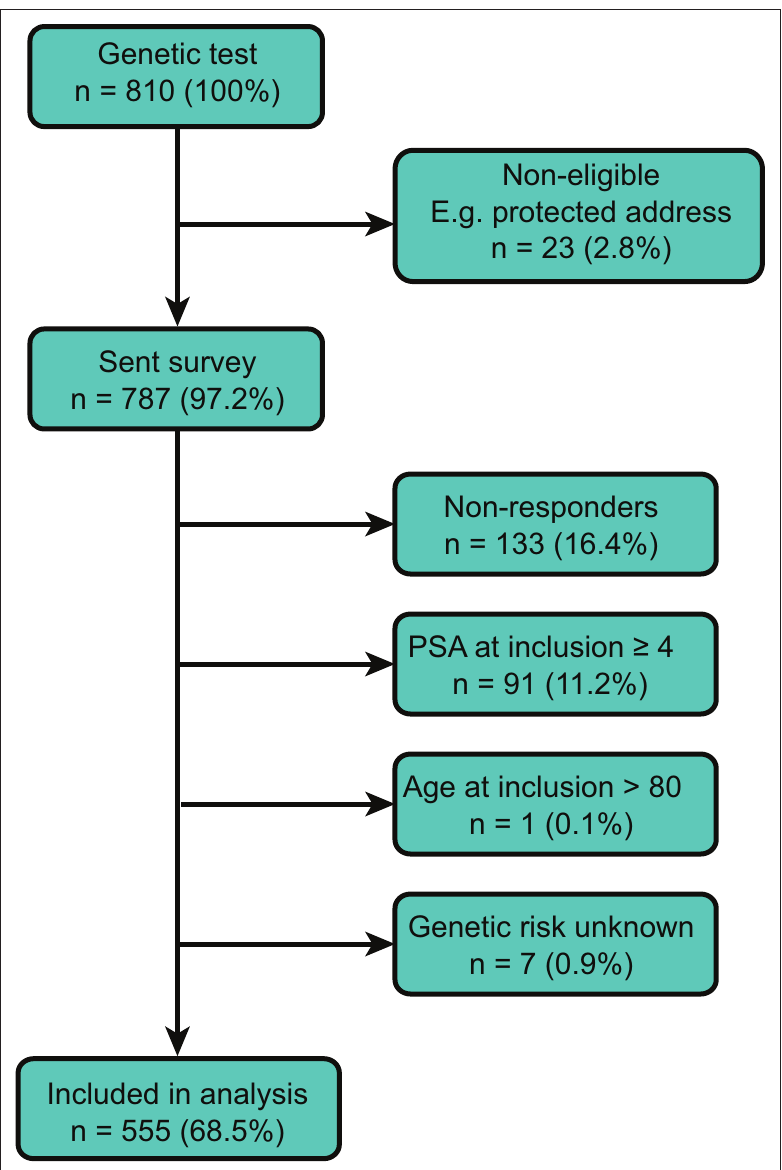
Figure 1 Flow chart of inclusion and exclusion criteria. PSA = prostate specific